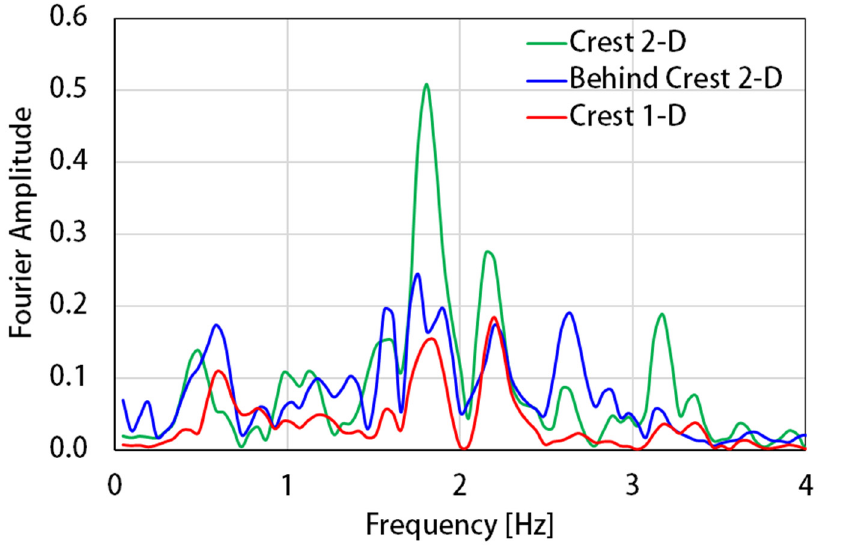
Figure 23. Comparison between Fourier amplitude spectra at the crest (1-D and 2-D) and behind the crest (2-D), for the Amoruso et al. [26] input.